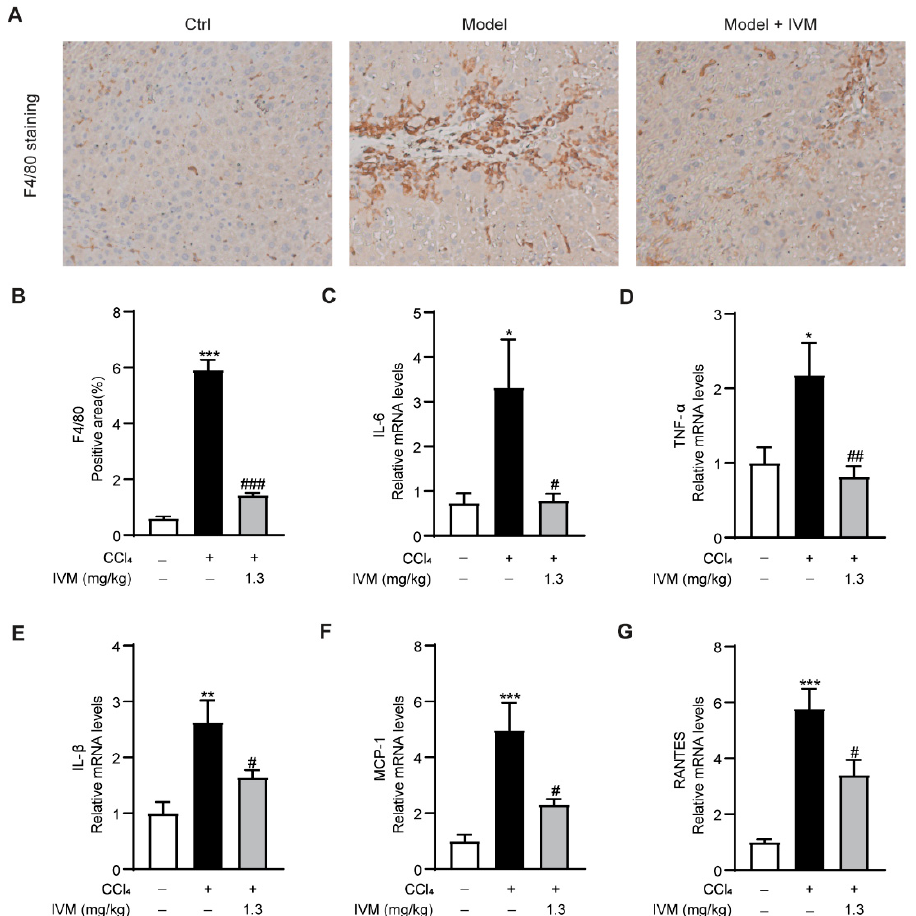
Figure 3. Anti-inflammatory effects of ivermectin in liver tissues from mice who received a CCl 4 injection: ( A ) hepatic F4/80 detection via immunohistochemistry (IHC) staining (original magnification, × 200) in liver tissues; ( B ) F4/80-positive area; ( C – G ) mRNA expression levels of IL-6, TNF- α , IL-1 β , MCP-1, and RANTES in liver tissues. Data are expressed as means ± SEM ( n = 6–8/group). Note: * p < 0.05, ** p < 0.01, *** p < 0.001 vs. control group, # p < 0.05, ## p < 0.01, ### p < 0.001